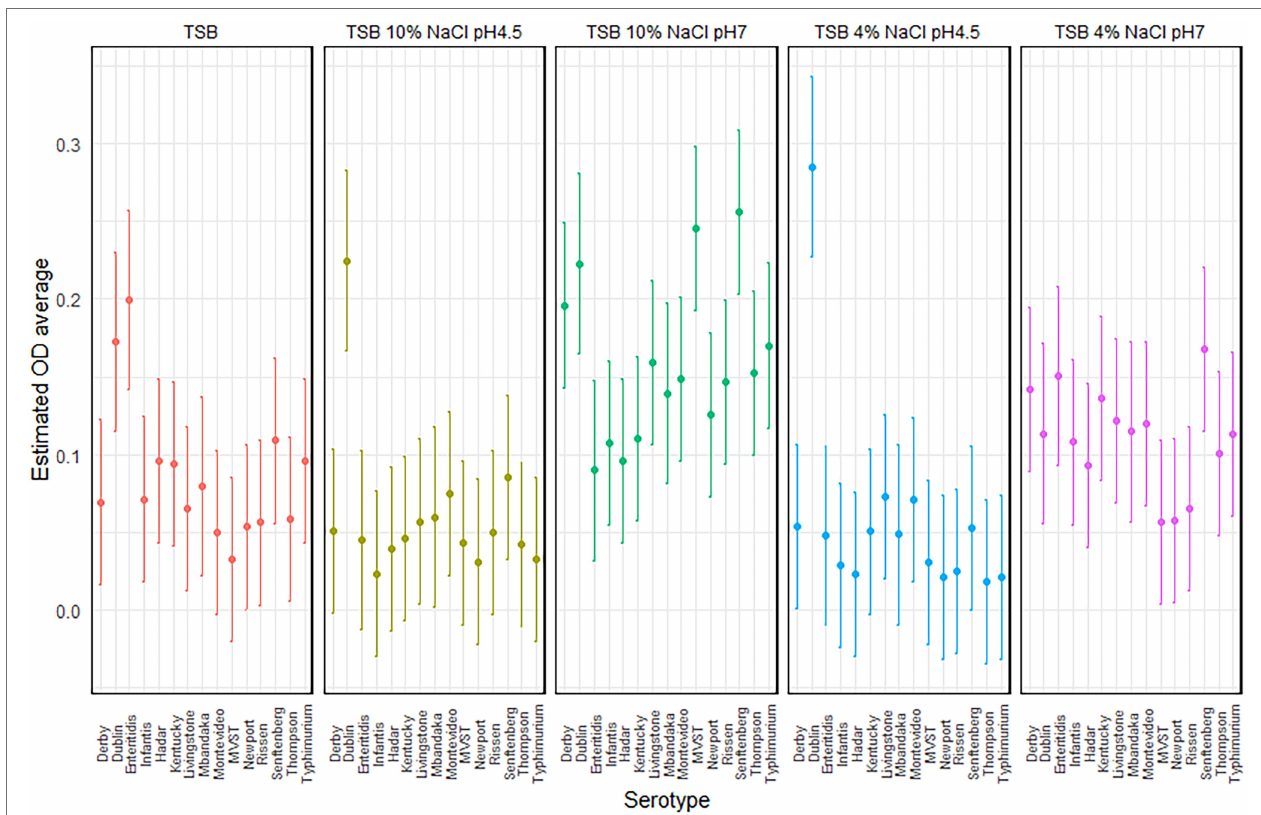
FIGURE 2 | Plot of the estimated average optical density (OD) and 95% CIs, per serotype and experimental